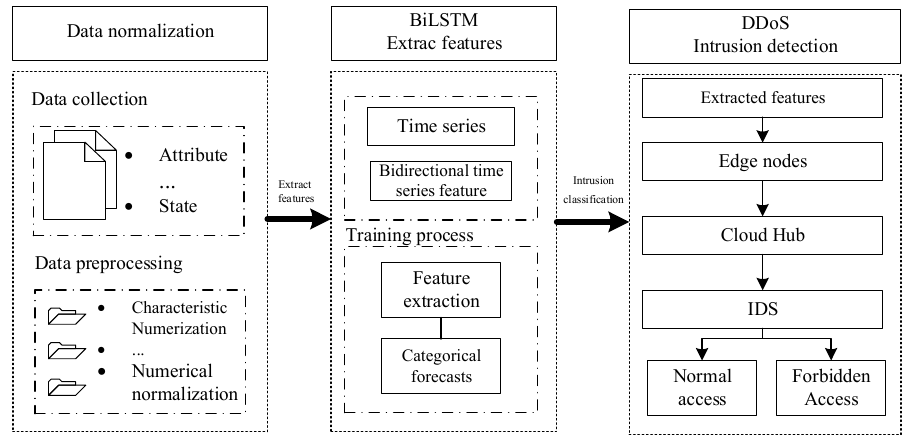
Figure 3. Overall frame diagram.